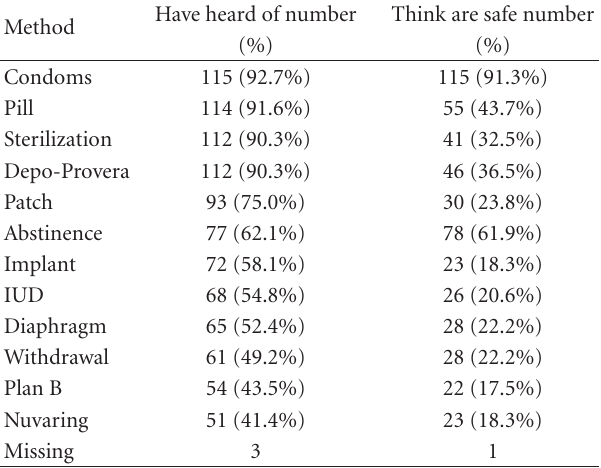
Table 3: Contraceptive methods HIV-positive subjects have heard of/think are safe to use.